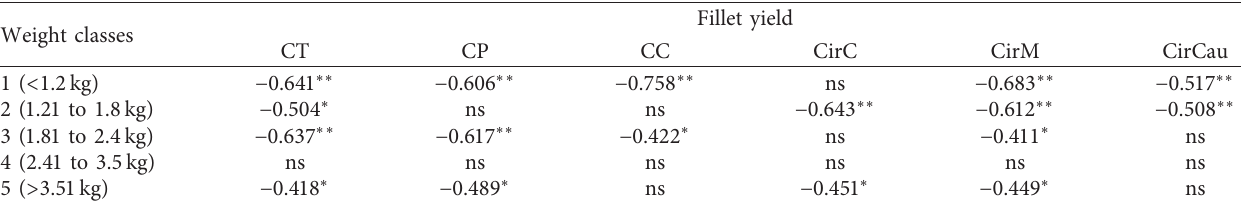
Table 3: Correlations between fillet yield and morphometric measurements in relation to the different weight classes of black pacu ( Colossoma macropomum ).